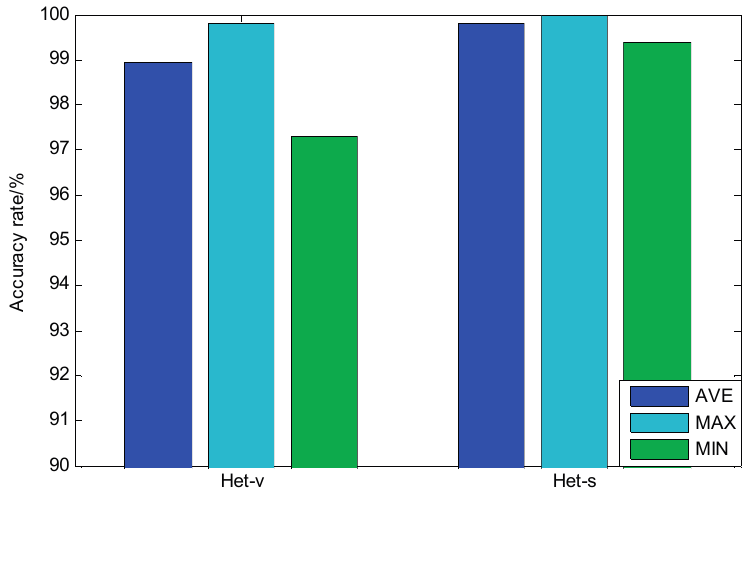
Figure 9. Comparison of major voting with stacking strategy for heterogeneous ensemble classifier (Het-v—heterogeneous ensemble with majority voting and Het-s—heterogeneous ensemble with